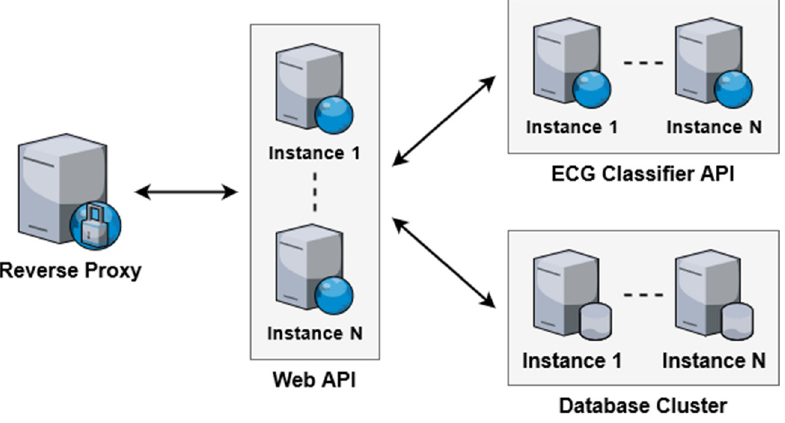
Figure 6. Dynamic scaling using multiple component instances.